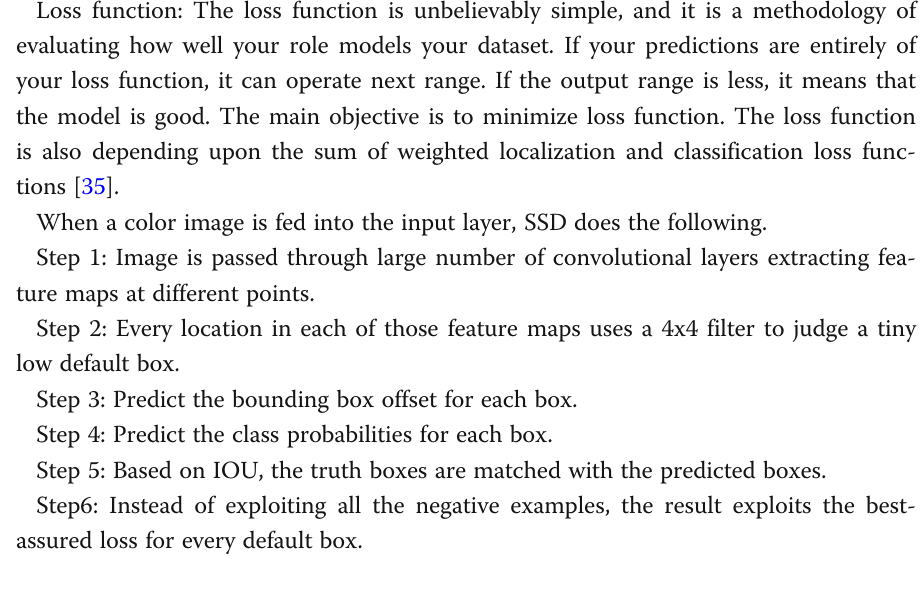
Single shot: This means that the tasks of the thing localization and classification are exhausted one passing play of the network.